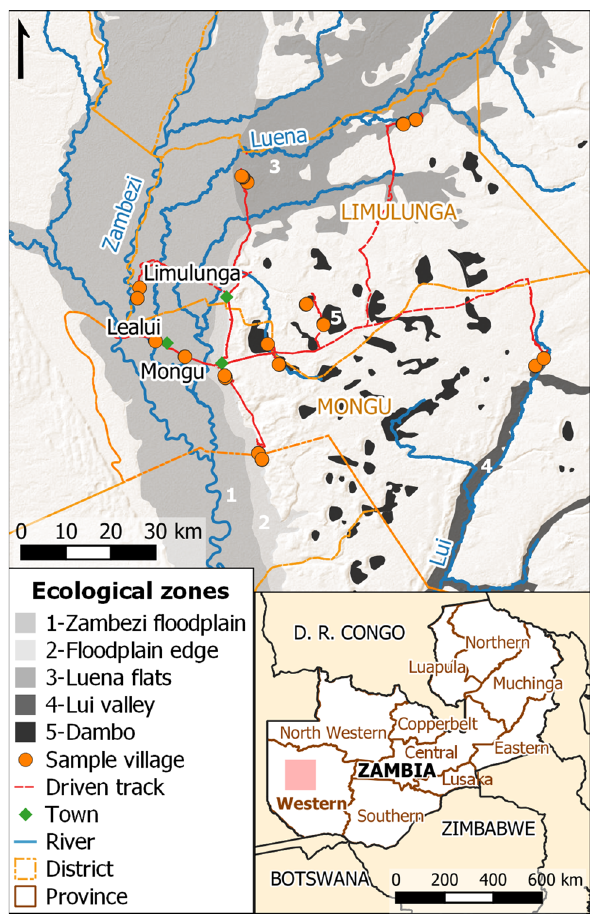
Figure 1. Ecological zones and entomological survey locations in Western Province, Zambia. 1 = Zambezi floodplain; 2 = Floodplain edge; 3 = Luena flats; 4 = Lui valley; 5 = dambos. Larval surveillance and adult mosquito trapping undertaken after the peak of the 2019 wet season. Pink rectangle in inset indicates study map extent. Map drawn in QGIS 94 (v. 3.18.3-Zürich; https:// www. qgis. org); basemap: ESRI Shaded Relief